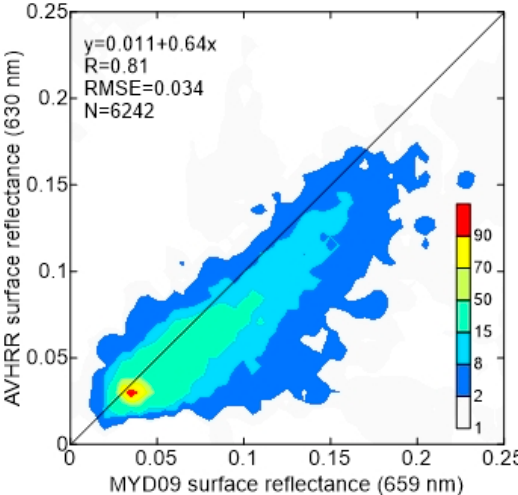
Figure 15. The scatter-density plot of the AVHRR-retrieved surface reflectance at 0.63 µ m (NP satellite) versus the MYD09 surface reflectance product at 0.66 µ m (Aqua satellite) over Eastern Asia on 24 September 2009. Data was sorted and binned into 0.005 × 0.005 boxes. The color scale indicates the number of collocations. The line is the 1:1 plot. The text describes the linear regression relationship, R , RMSE error, and number of collocations (N).